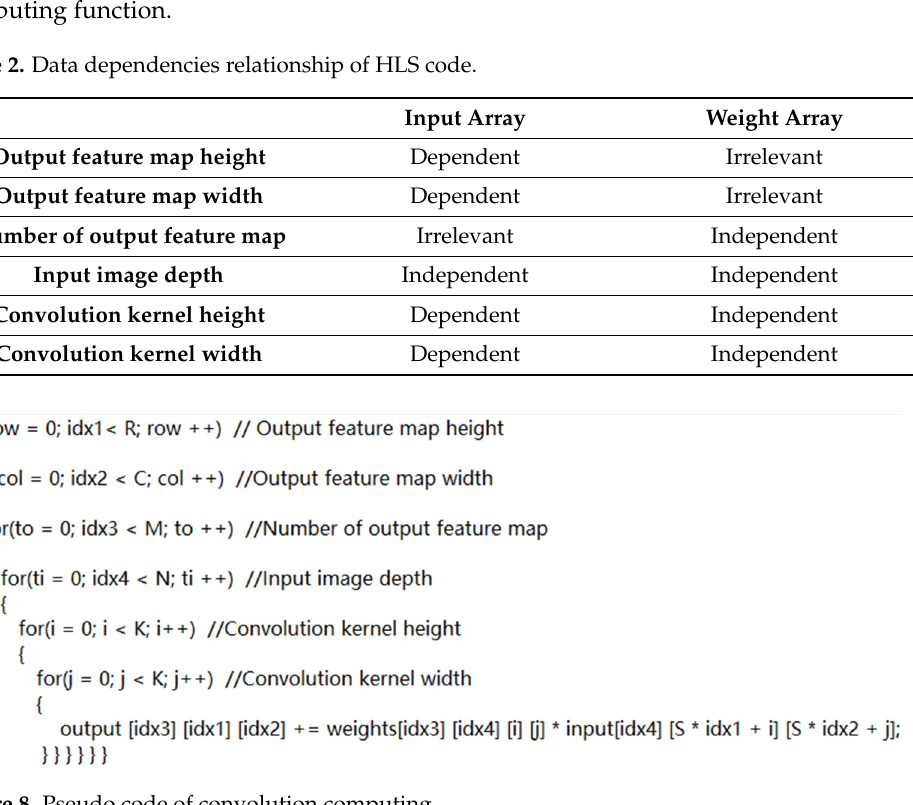
Figure 7. The overall design of the framework.